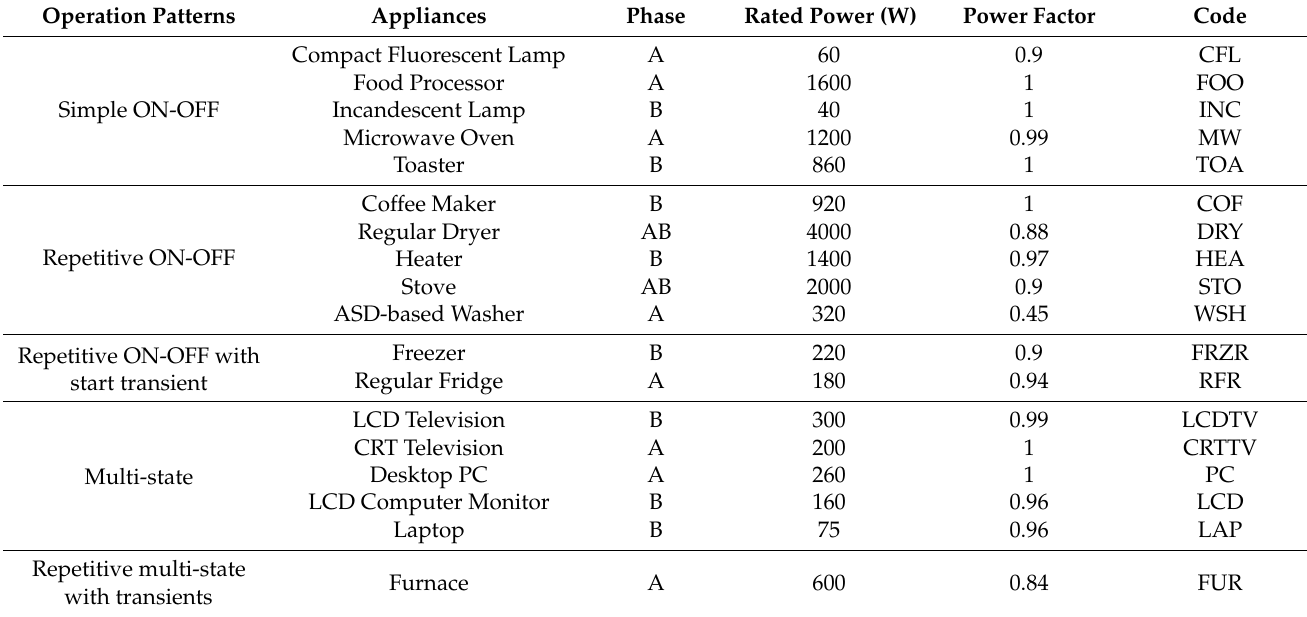
Table 1. The basic information of simulated